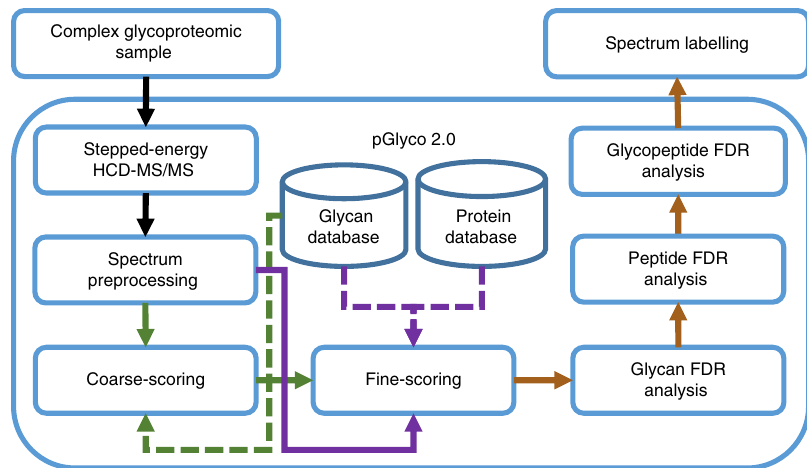
Fig. 2 Design of a dedicated software for intact glycopeptide